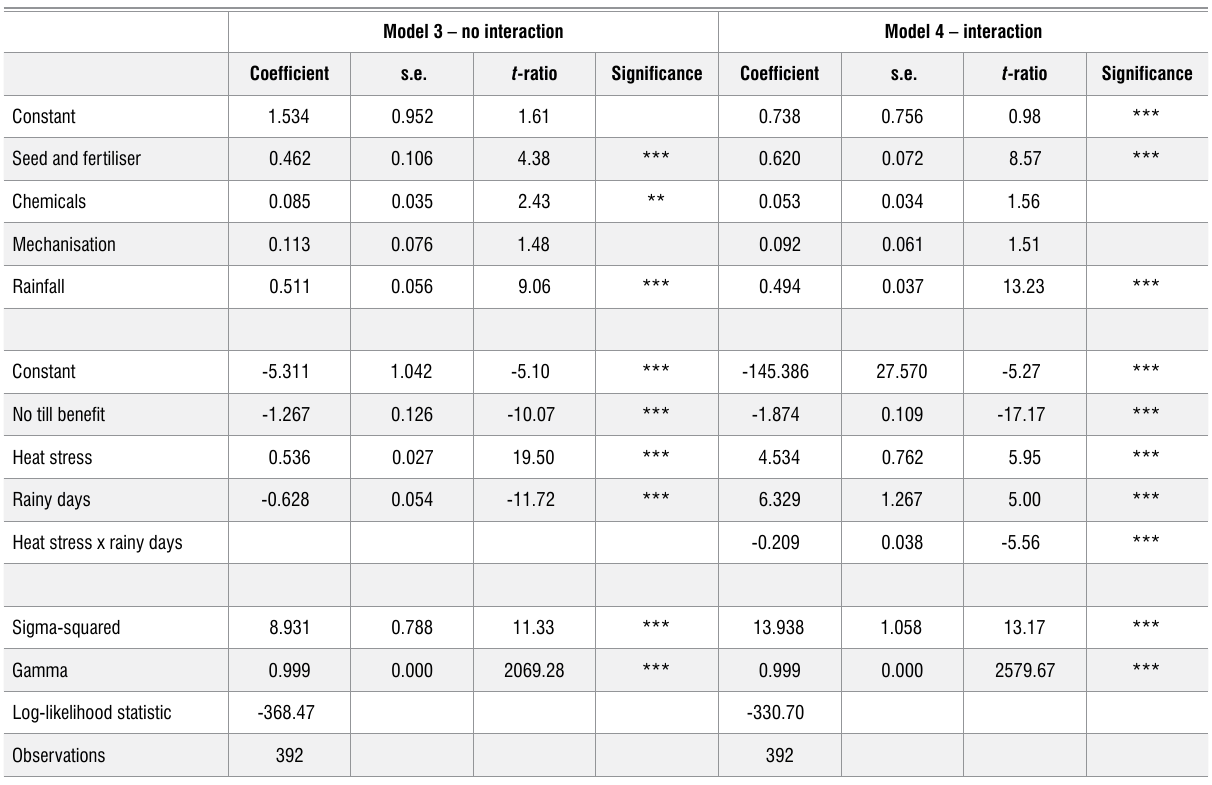
Table 4: Grain productivity model testing the number of rainy days as drought